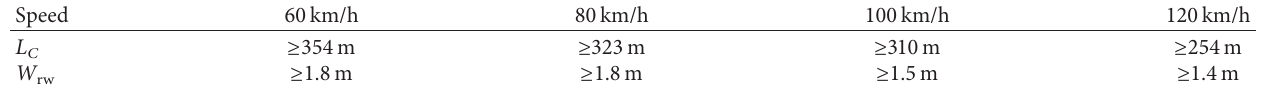
Table 5: Water length and width threshold of handing